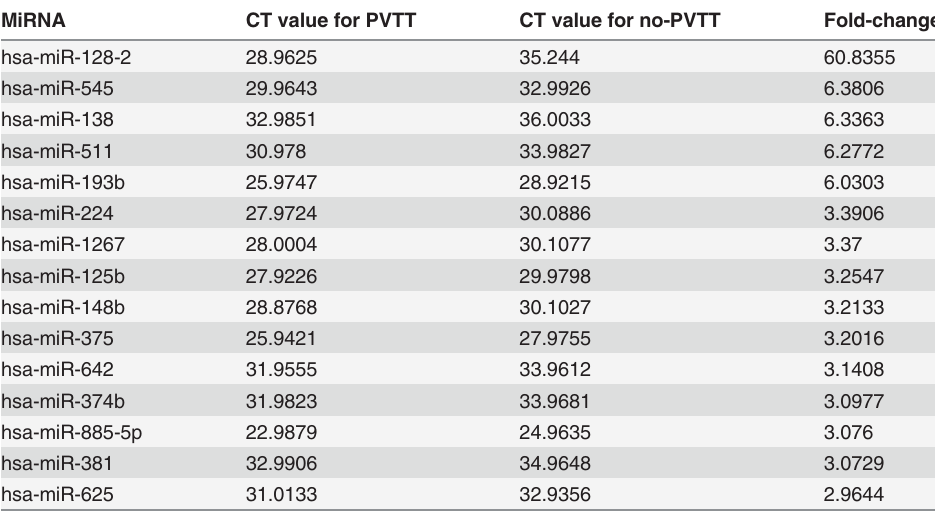
Table 2. Serum miRNAs overexpressed in HCC patients with PVTT in comparison with no PVTT. MiRNA CT value for PVTT CT value for